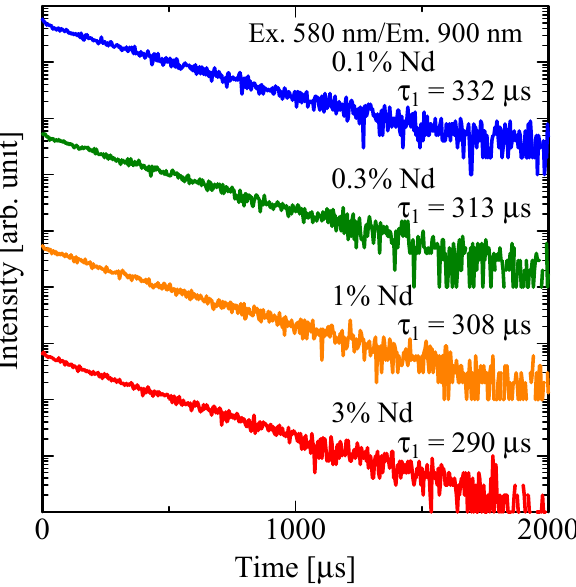
Figure 4. PL decay curves of LaMgAl 11 O 19 :Nd monitored at 900 nm when excited at 580 nm. Table 1. PL QY , decay time constant ( τ ), radiative ( k f ) and nonradiative decay rates ( k nr ) calculated from PL QY and decay time